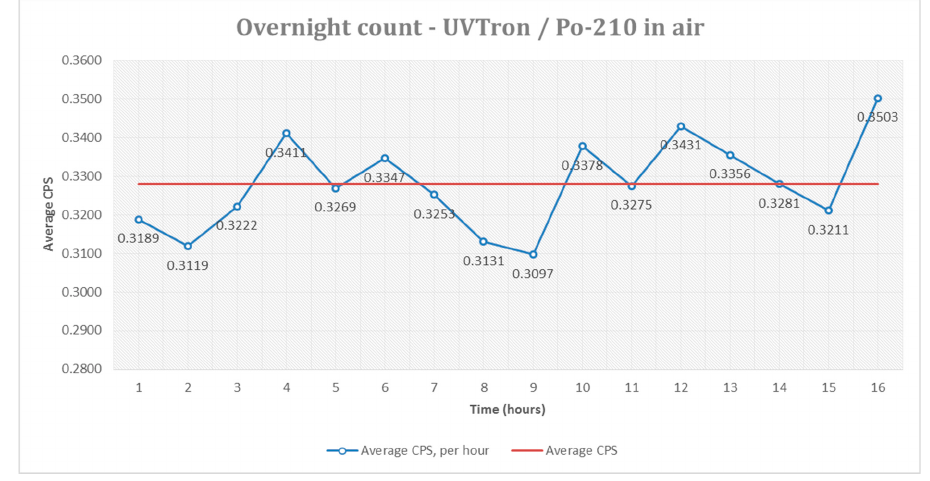
Figure 5. Average counts per second (cps) per hour— 210 Po source in air.